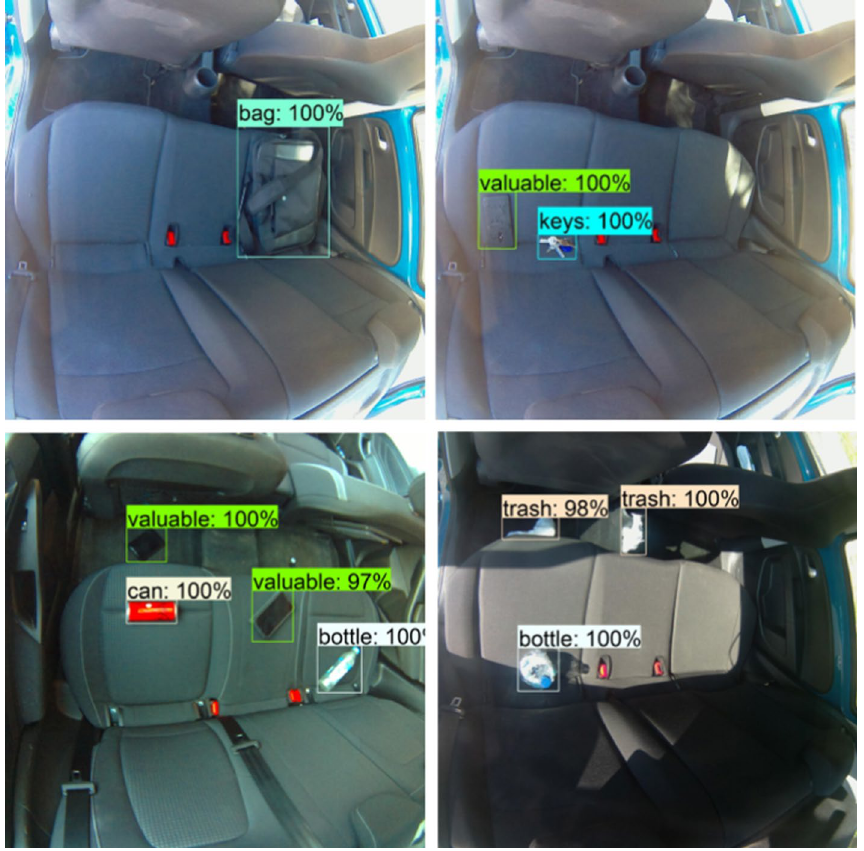
Fig. 21 Examples of successful detections